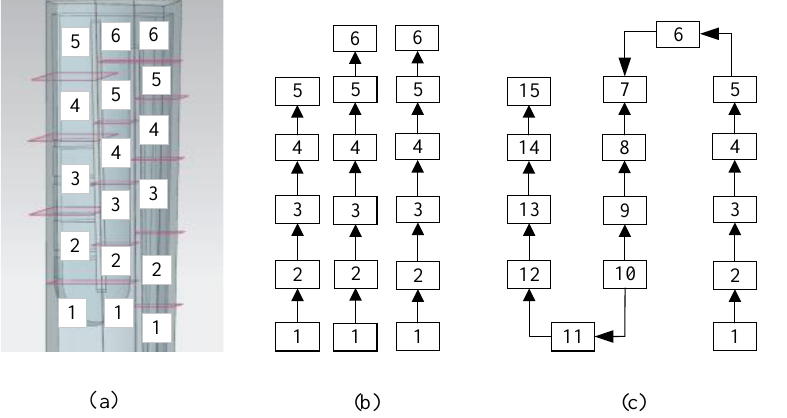
Figure 22. Connection relationship of the main flow channel units: ( a ) main channel units, ( b ) seg- mented flow channel unit connectivity, and ( c ) combination of multi-stage flow channel